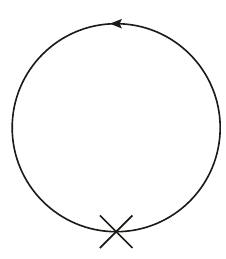
Figure 13 . The Feynman diagram corresponding to the one-loop stress-energy tensor for fermions. The cross indicates the fermionic stress-energy tensor insertion defined by